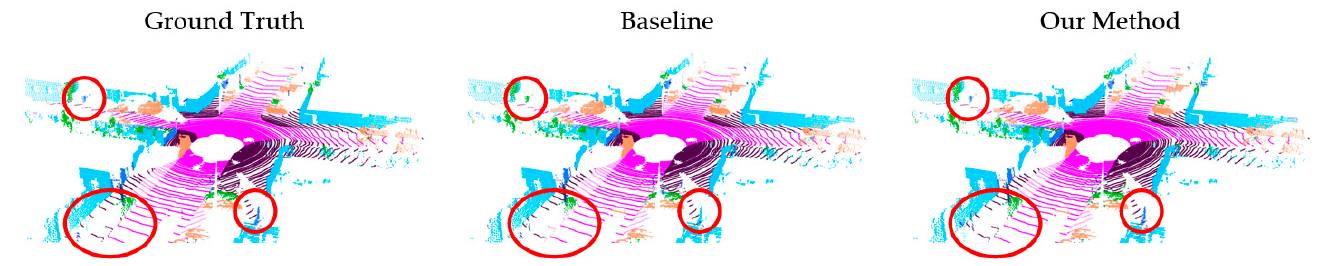
curacy in the corresponding columns.